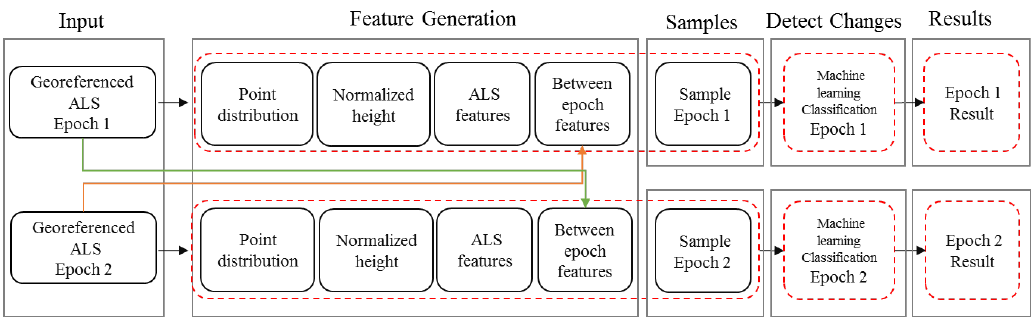
Figure 1. Flowchart of the proposed method.